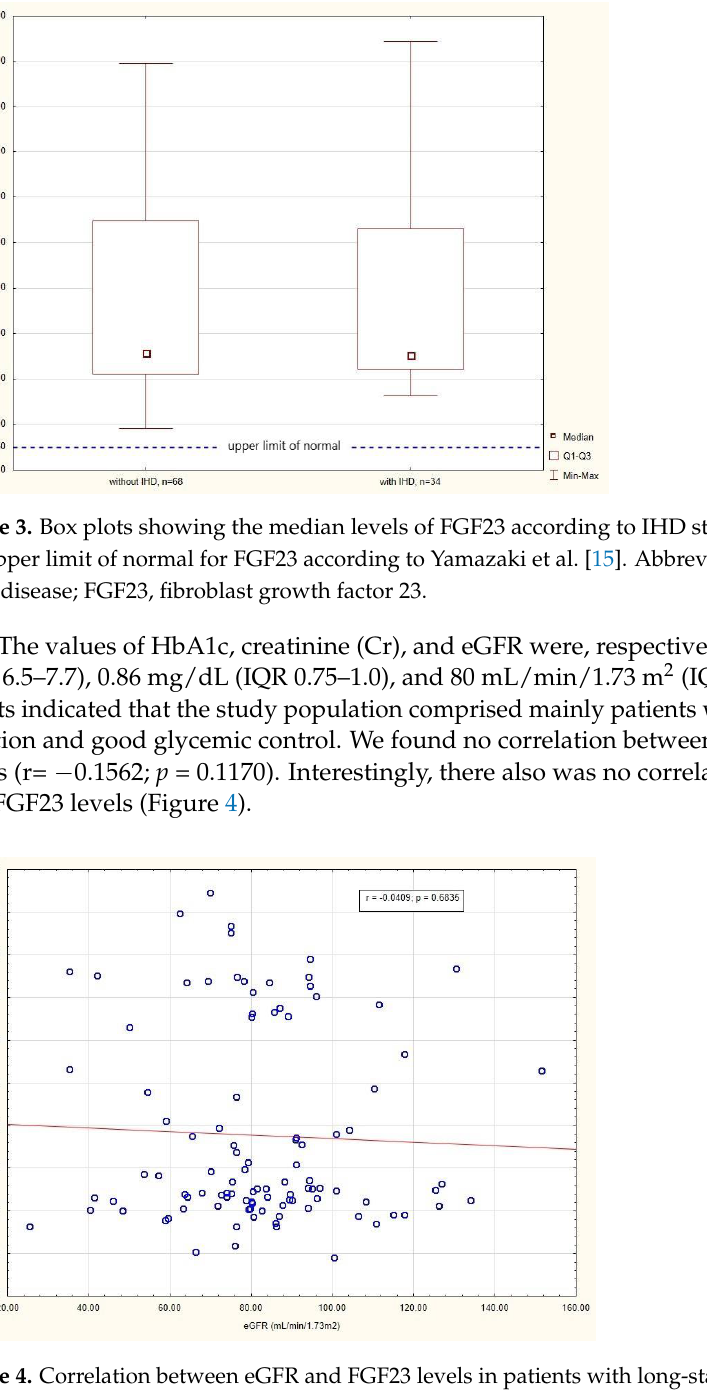
Figure 4. Correlation between eGFR and FGF23 levels in patients with long-standing type 2 diabetes mellitus. Abbreviations: eGFR, estimated glomerular filtration; FGF23, fibroblast growth factor 23. A lipid profile consisted of the following tests: total cholesterol (TC) (152.0 mg/dL, IQR 125.0–186.0), high-density lipoprotein cholesterol (HDL-C) (49.0 mg/dL, IQR 42.0–59.0), low-density lipoprotein cholesterol (LDL-C) (72.0 mg/dL, IQR 51.0–98.0),